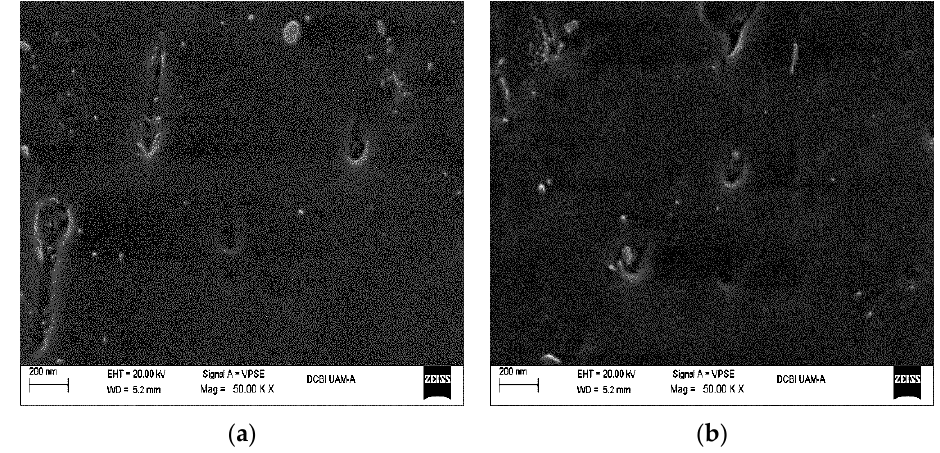
Figure 19. ( a , b ) SEM micrographs of the hybrid material, show the deformation of the organic matrix due to the energy dissipation at 50 K×.